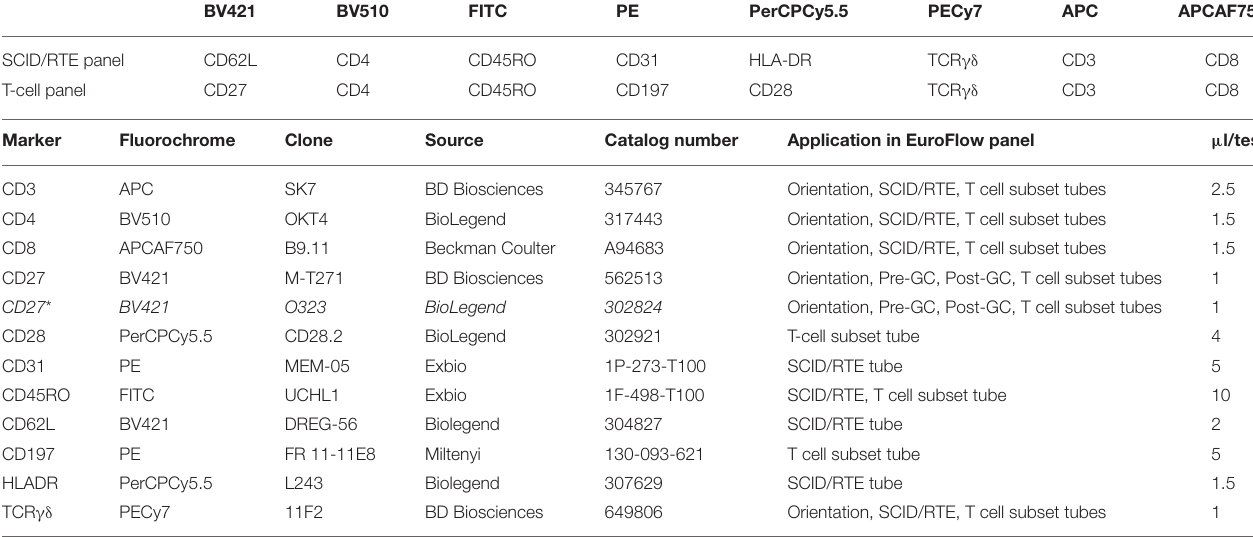
TABLE 4 | Composition of the 8-color BM-BCP tube and technical information on